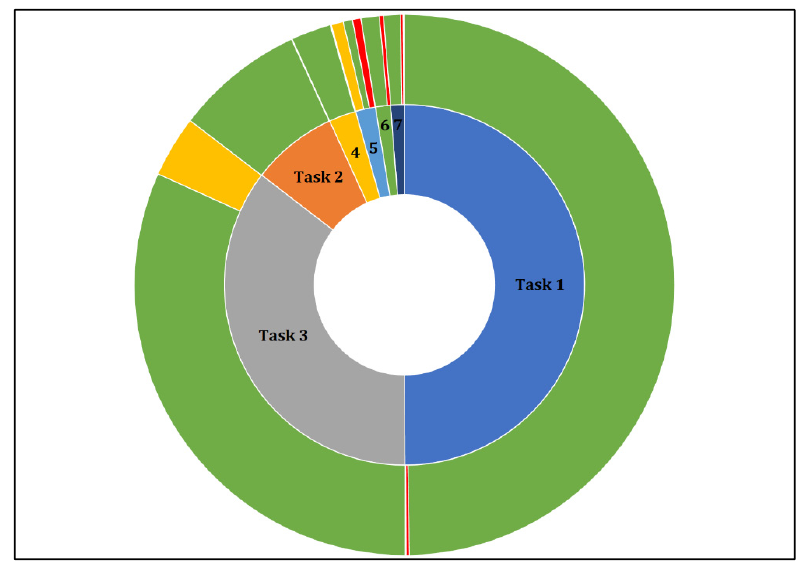
Figure 11. Relative number of parcels affected by the individual checking tasks together with the outcome of the check: Green (eligible); yellow (uncertain); red (ineligible). outcome of the check: Green (eligible); yellow (uncertain); red